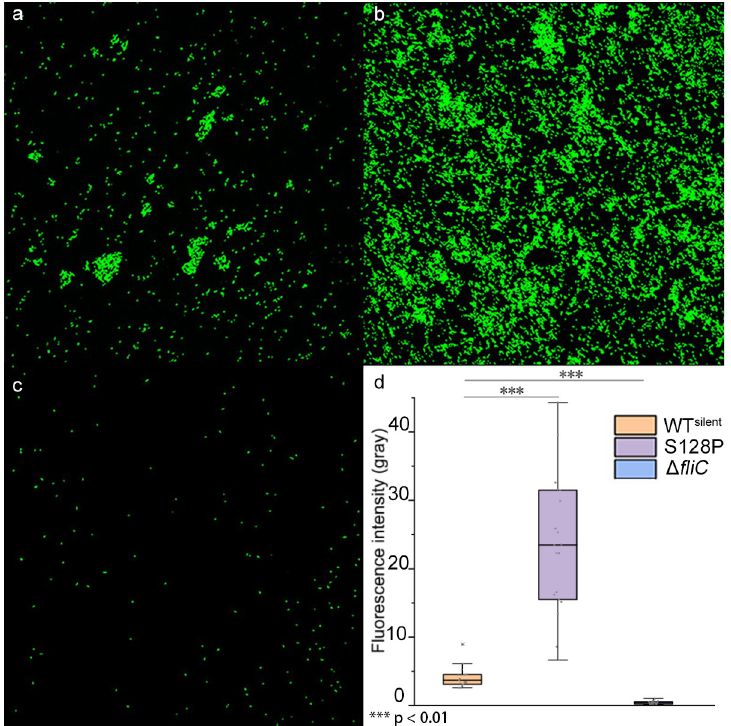
Fig 4. Confocal laser scanning microscopy of fluorescence in GFP-labeled (a) Xoc WT silent , (b) S128P mutant, and (c) Δ fliC mutant. Panel (d) shows fluorescence intensity in GFP-labeled Xoc WT silent , S128P, and Δ fliC . Bacteria were grown under static conditions at 28˚C for 96 h on glass coverslips. Biofilms were fixed, and fluorescence intensity was randomly measured from 12 parallel replicates. ��� , P < 0.001, Wilcoxon rank-sum test.